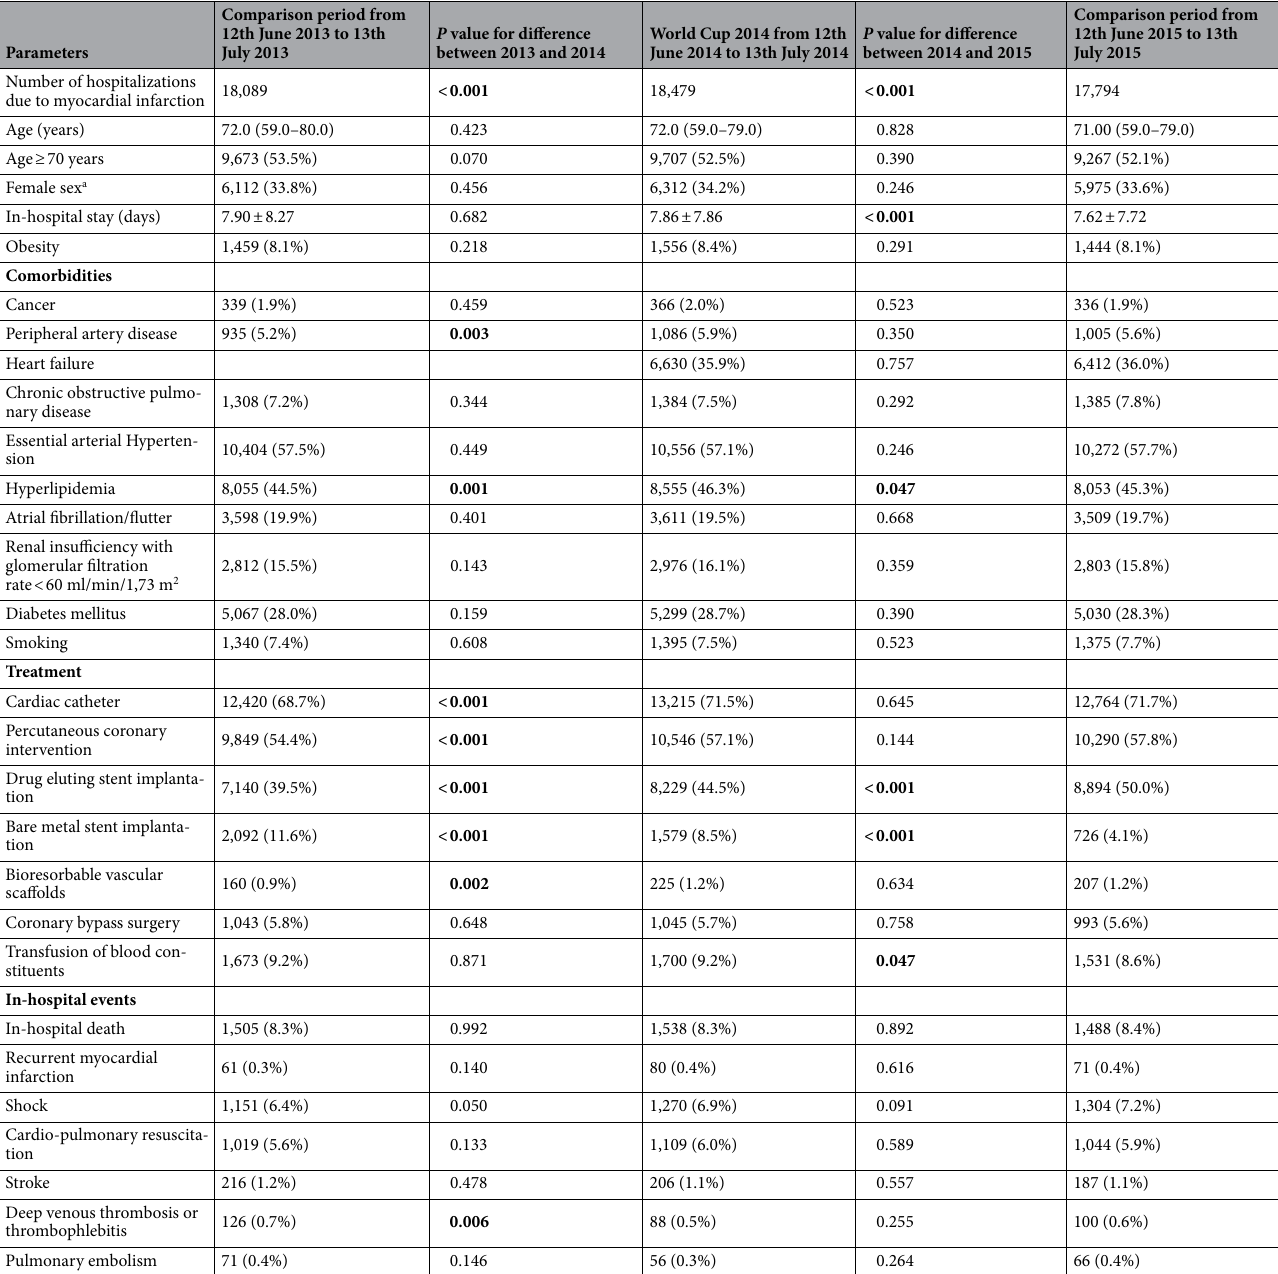
Table 1. Patients’ characteristics of 54,362 patients admitted for MI during the World Cup 2014 from 12th June 2014 to 13th July 2014 and in the comparison periods from 12th June 2013 to 13th July 2013 as well as 12th June 2015 to 13th July 2015 without soccer World Cup. a Data about patients’ gender was available in 54,361